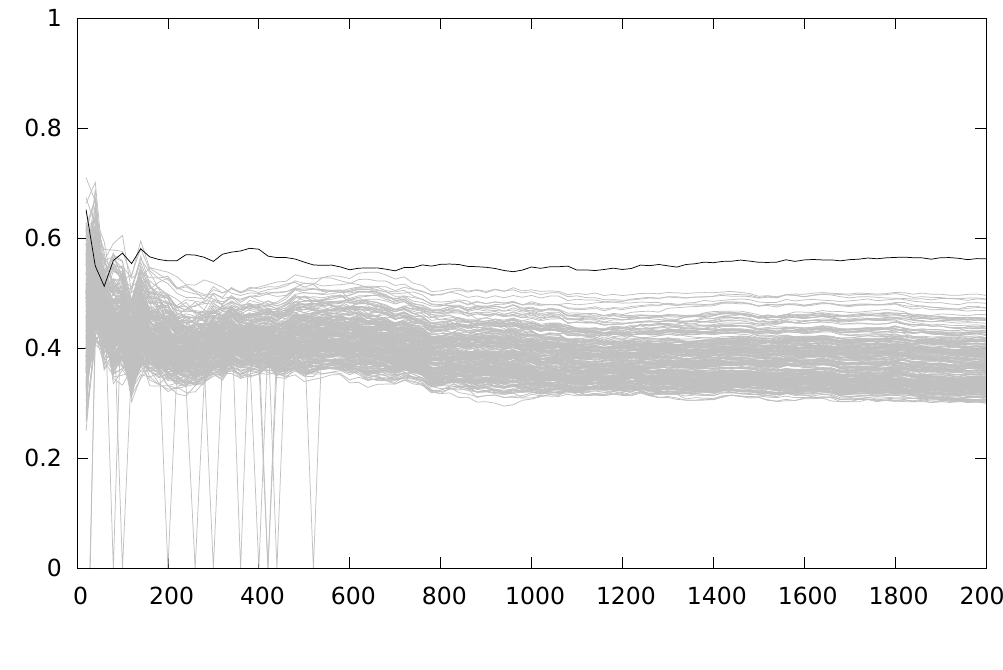
Figure 12. Maximum correlation in region of interest for different key guesses vs . number of power traces when switching randomly between 3 implementations (2, 3 iterations and no unrolling) attacking with window of size